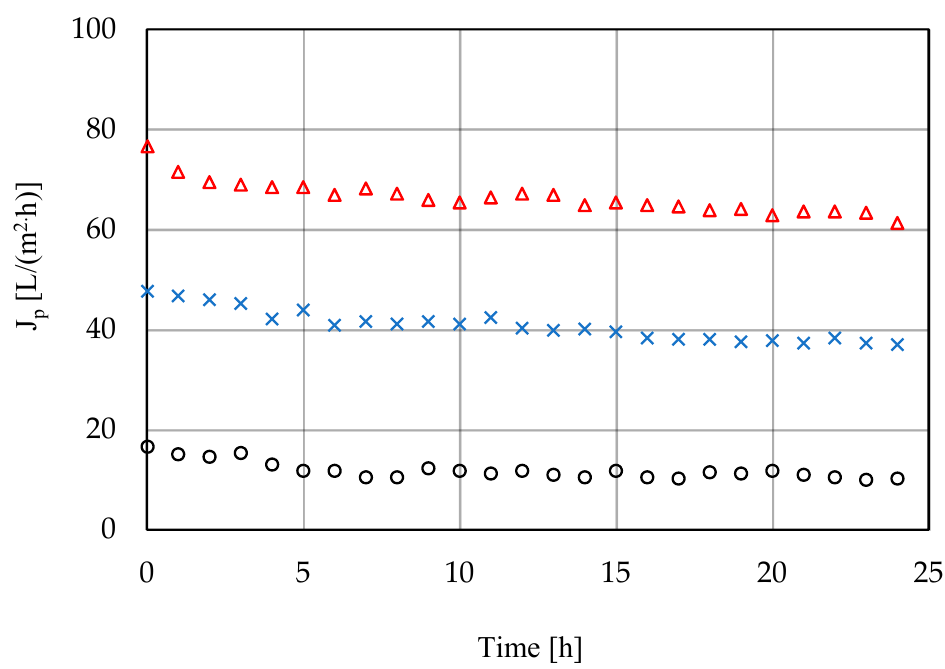
Figure 5. Permeate flux change during the reverse osmosis process; PCI RO membrane, T = 25 °C (o, 1.0 MPa; ×, 2.0 MPa; Δ , 3.0 MPa). Points represent the average of five measurements. The removal efficiency of the selected compounds during high-pressure filtration, expressed as the concentration of a given compound in the permeate to its concentration in the feed, is shown in Figure 6.